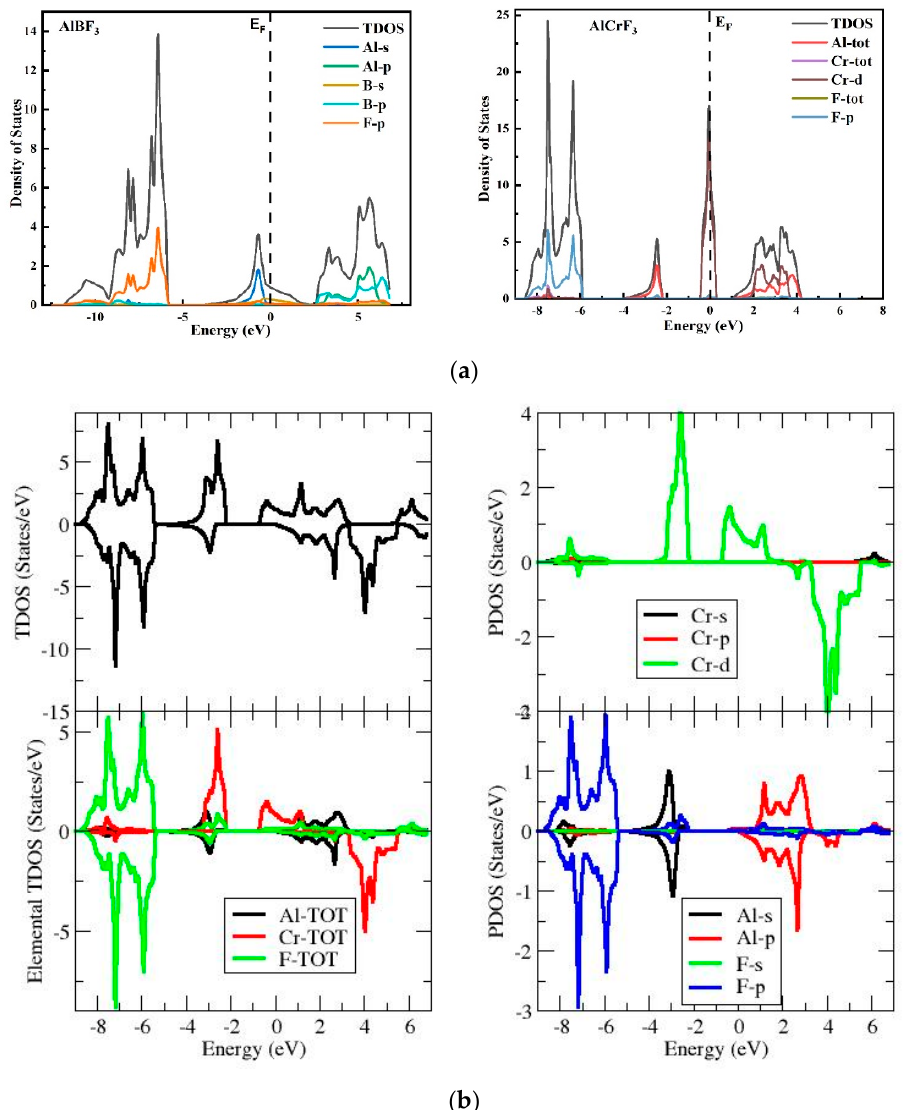
Figure 4. ( a ) Represents TDOS and PDOS of ternary AlMF 3 fluoroperovskites (M = Cr, B) using GGA. ( b ) Represents TDOS and PDOS of ternary AlCrF 3 fluoroperovskites using GGA + U. TDOS and PDOS for the stress ‐ free AlCrF 3 compound with and without incorporat ‐